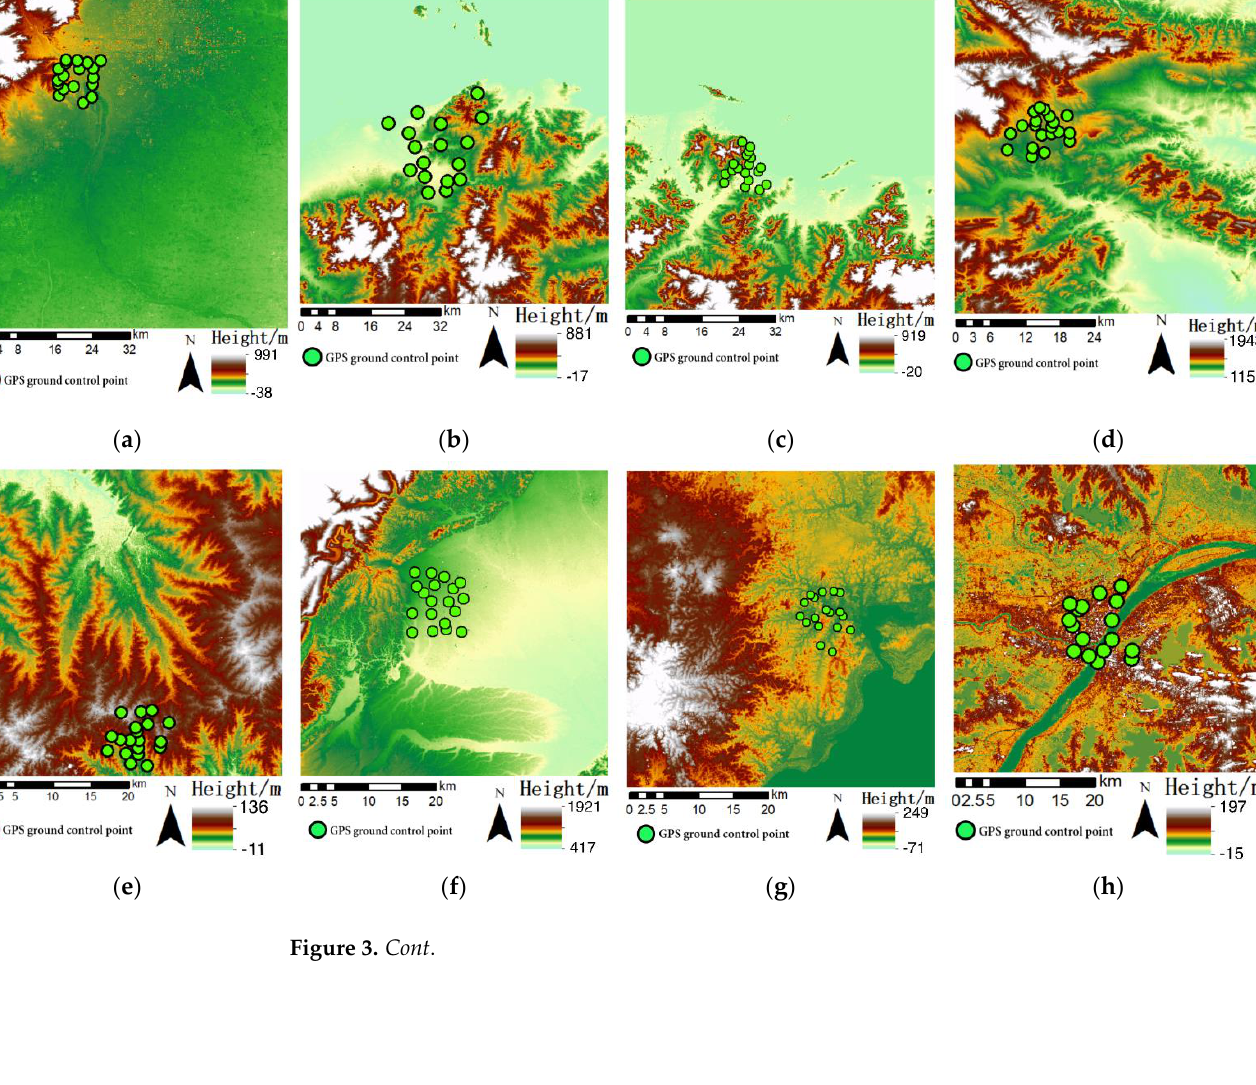
Figure 2. Distribution of the sixteen test fields.